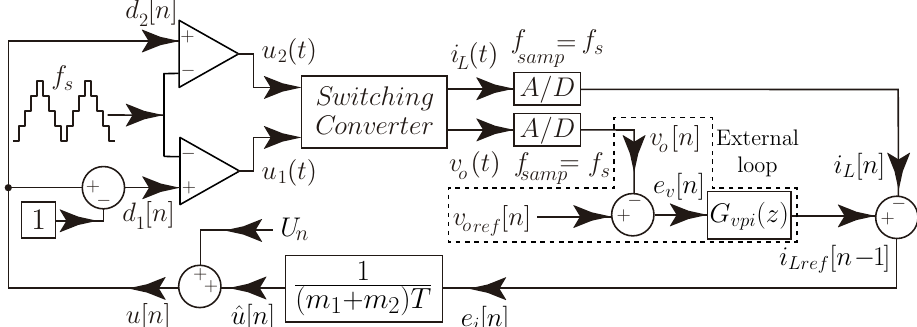
Figure 5. Schematic diagram of the two-loop control using DSMCC